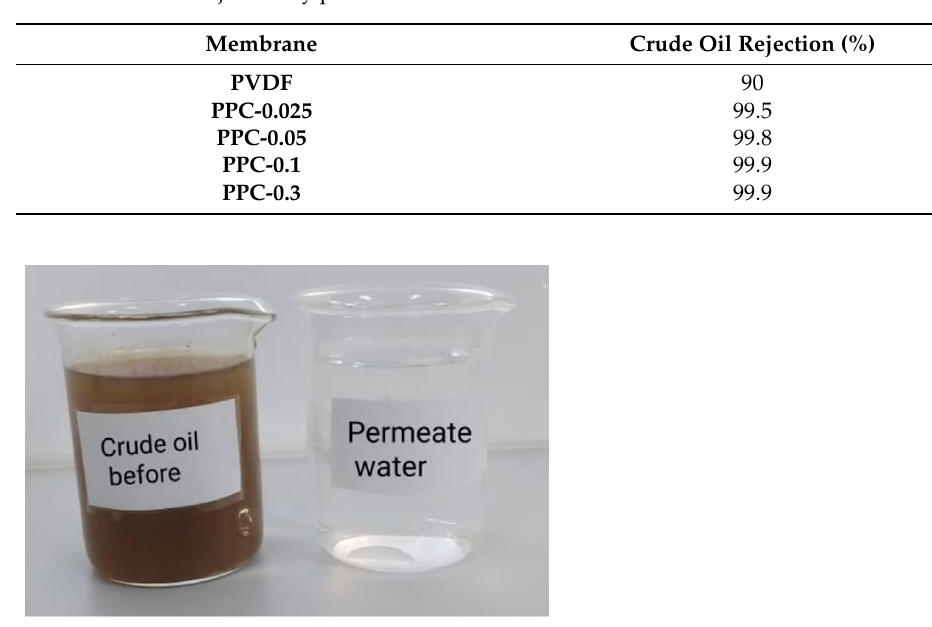
Table 6. Crude oil rejection by permeation cell.